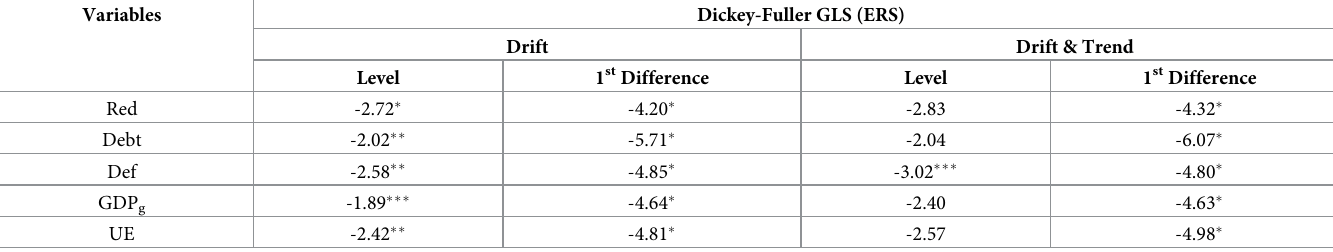
Table 5. Stationarity evidence from Dickey-Fuller GLS (ERS)